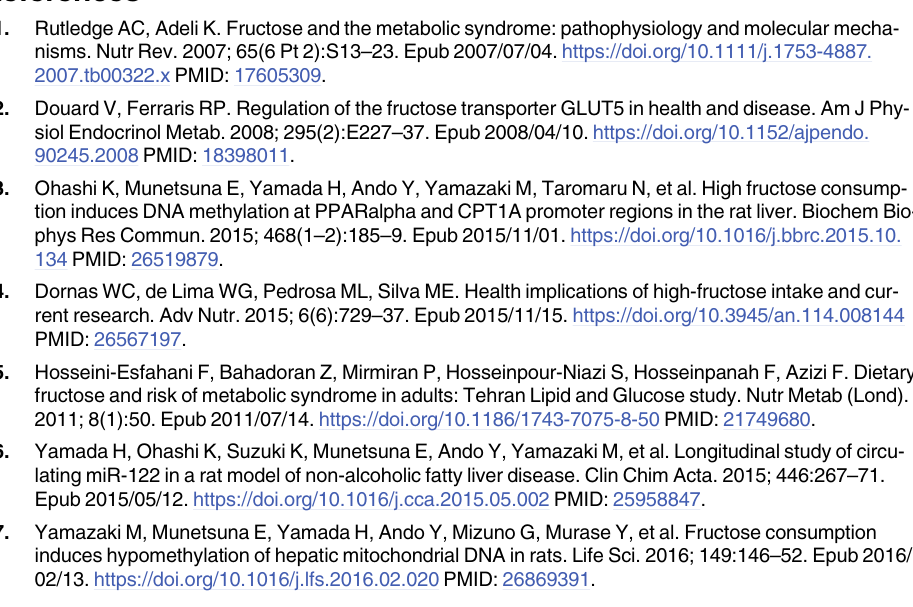
S1 Table. All data for gene expression analysis. The table shows the Ct value determined by the real-time PCR method. S1 Fig. Gel images for western blotting analysis are shown. The membranes were cut according to the molecular weight of the target